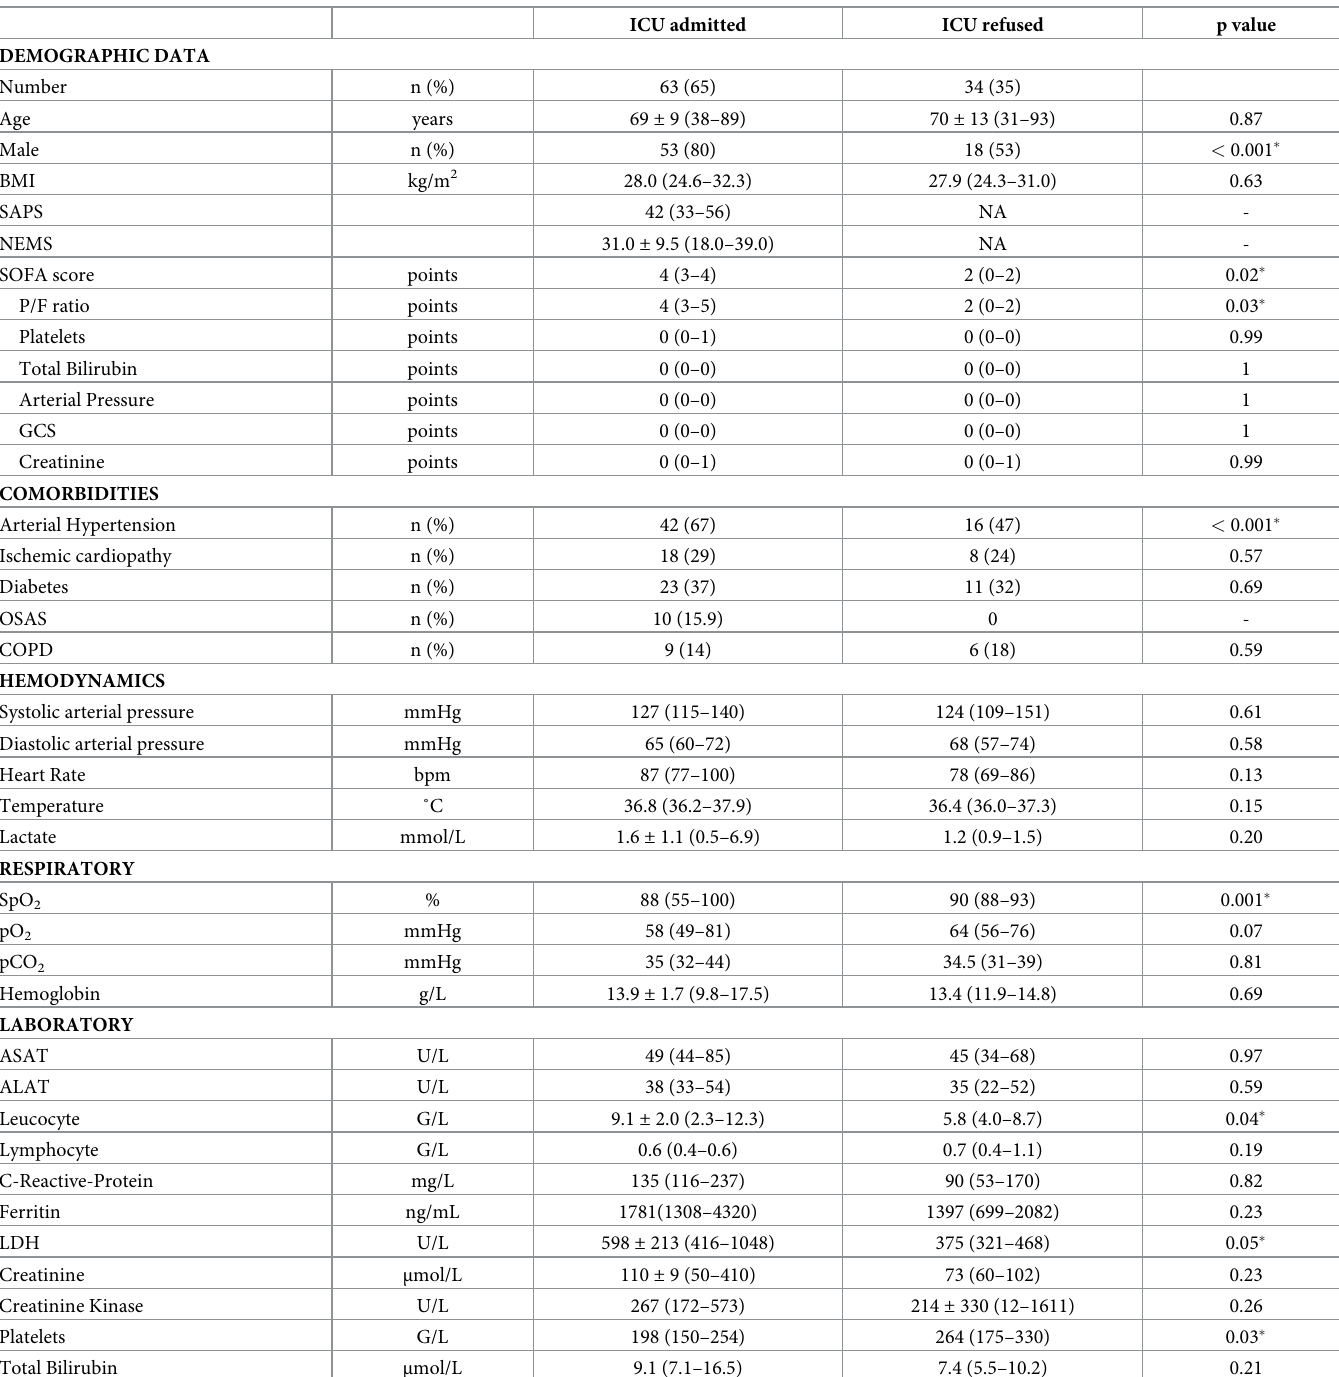
Table 1. Baseline characteristics at intensivist